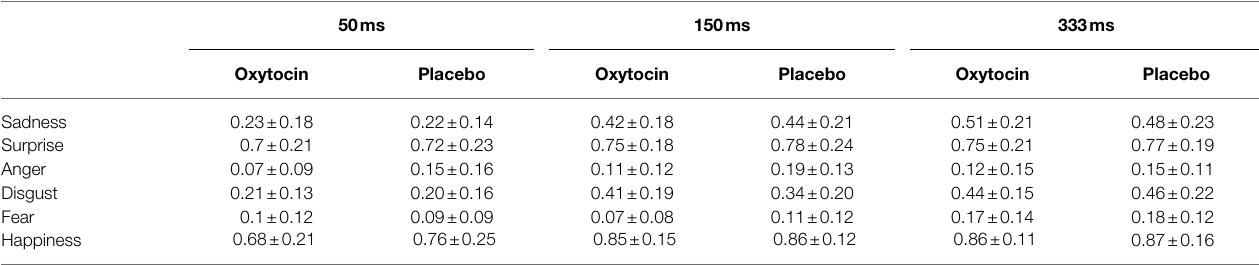
TABLE 1 | The recognition accuracy of standardized micro-expression recognition task in Study 1 ( M ± SD